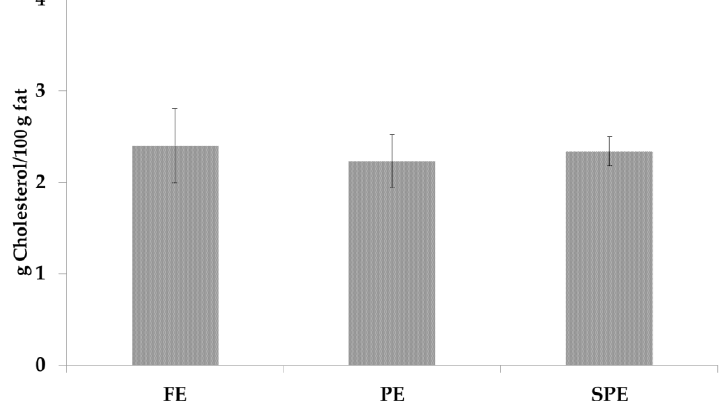
the cholesterol content (Figure 2).